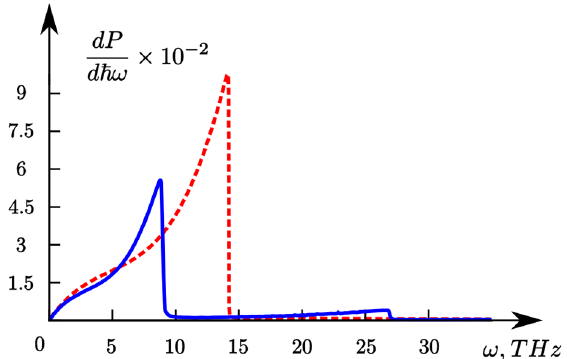
FIG. 5. Photon yield for single electron calculated numerically for N 1 ¼ 37 large amplitude averaged oscillations (blue curve). For N 1 → ∞ small amplitude averaged oscillations the spectrum is characterized by (15) and is presented by the red dashed curve. All the conditions ( I ¼ 10 11 W cm − 2 , α ¼ 75 ° and electron energy 20 MeV) except the initial transverse position for these cases are